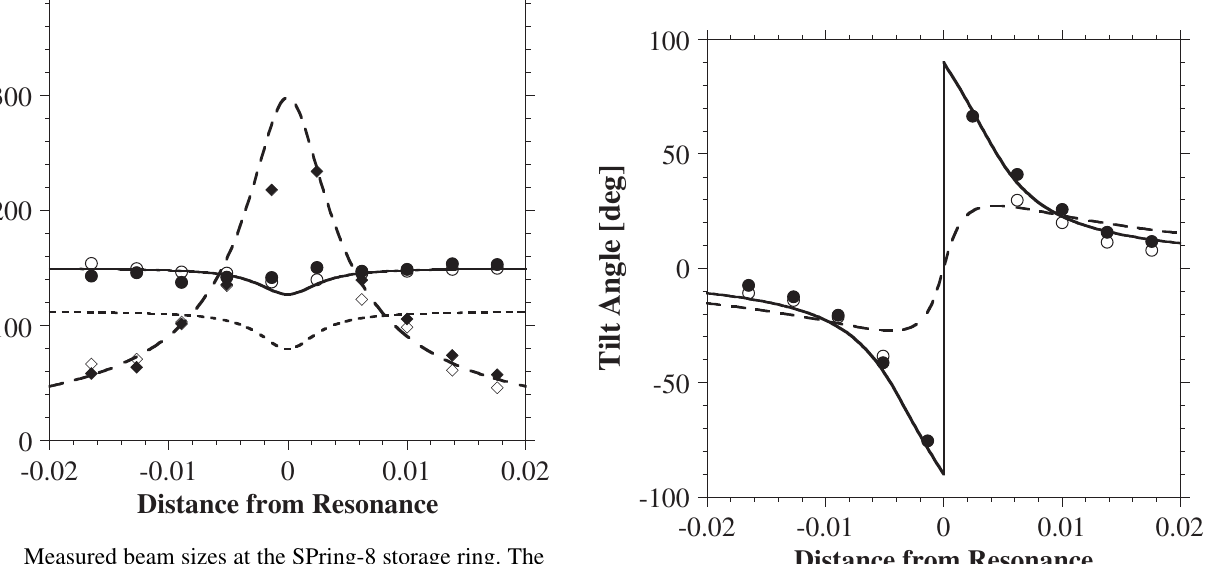
FIG. 2. Measured beam sizes at the SPring-8 storage ring. The solid and open circles denote the horizontal beam sizes measured by the x-ray beam profile monitor and by the visible light interferometer, respectively. The diamonds indicate the vertical ones. The solid (dotted) line represents the expected horizontal beam size calculated with (without) the contribution of the energy spread through the dispersion. The dashed line indicates the expected vertical beam size.